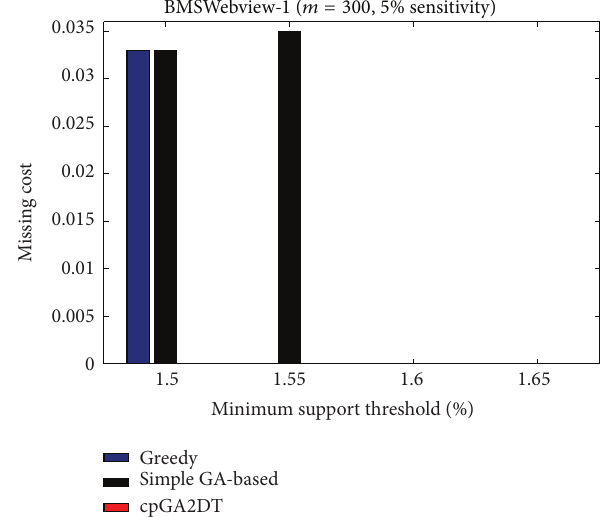
Figure 21: Comparisons of missing cost at various minimum support thresholds for BMSWebview-1 database.